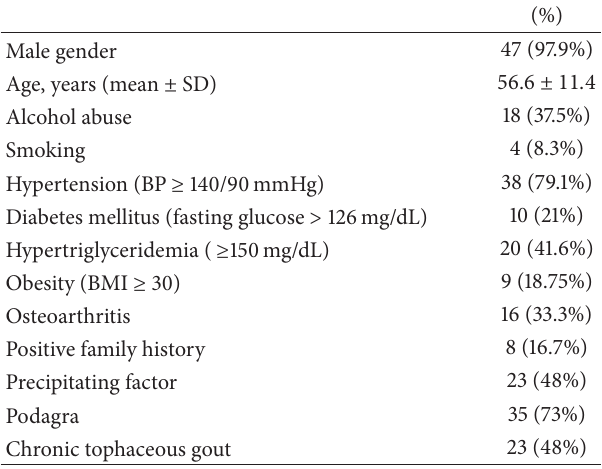
Table 1: Basal characteristics of the study population ( 𝑛 = 48